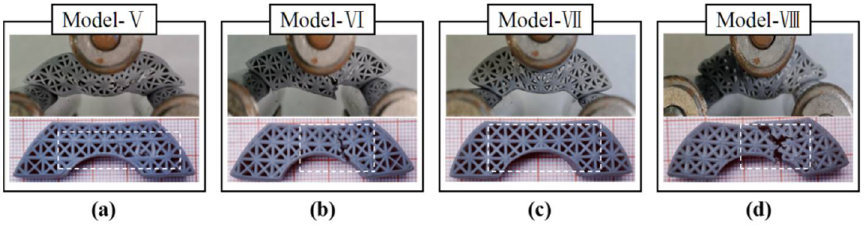
Figure 12. The failure modes of the topology-optimized structures: ( a ) FL–heterogeneous lattice No. 1, ( b ) FL–heterogeneous lattice No. 2, ( c ) Lattice hybrid structure with FCC strut diameter of 0.8 mm, ( d ) Lattice hybrid structure with FCC strut diameter of 1 mm.